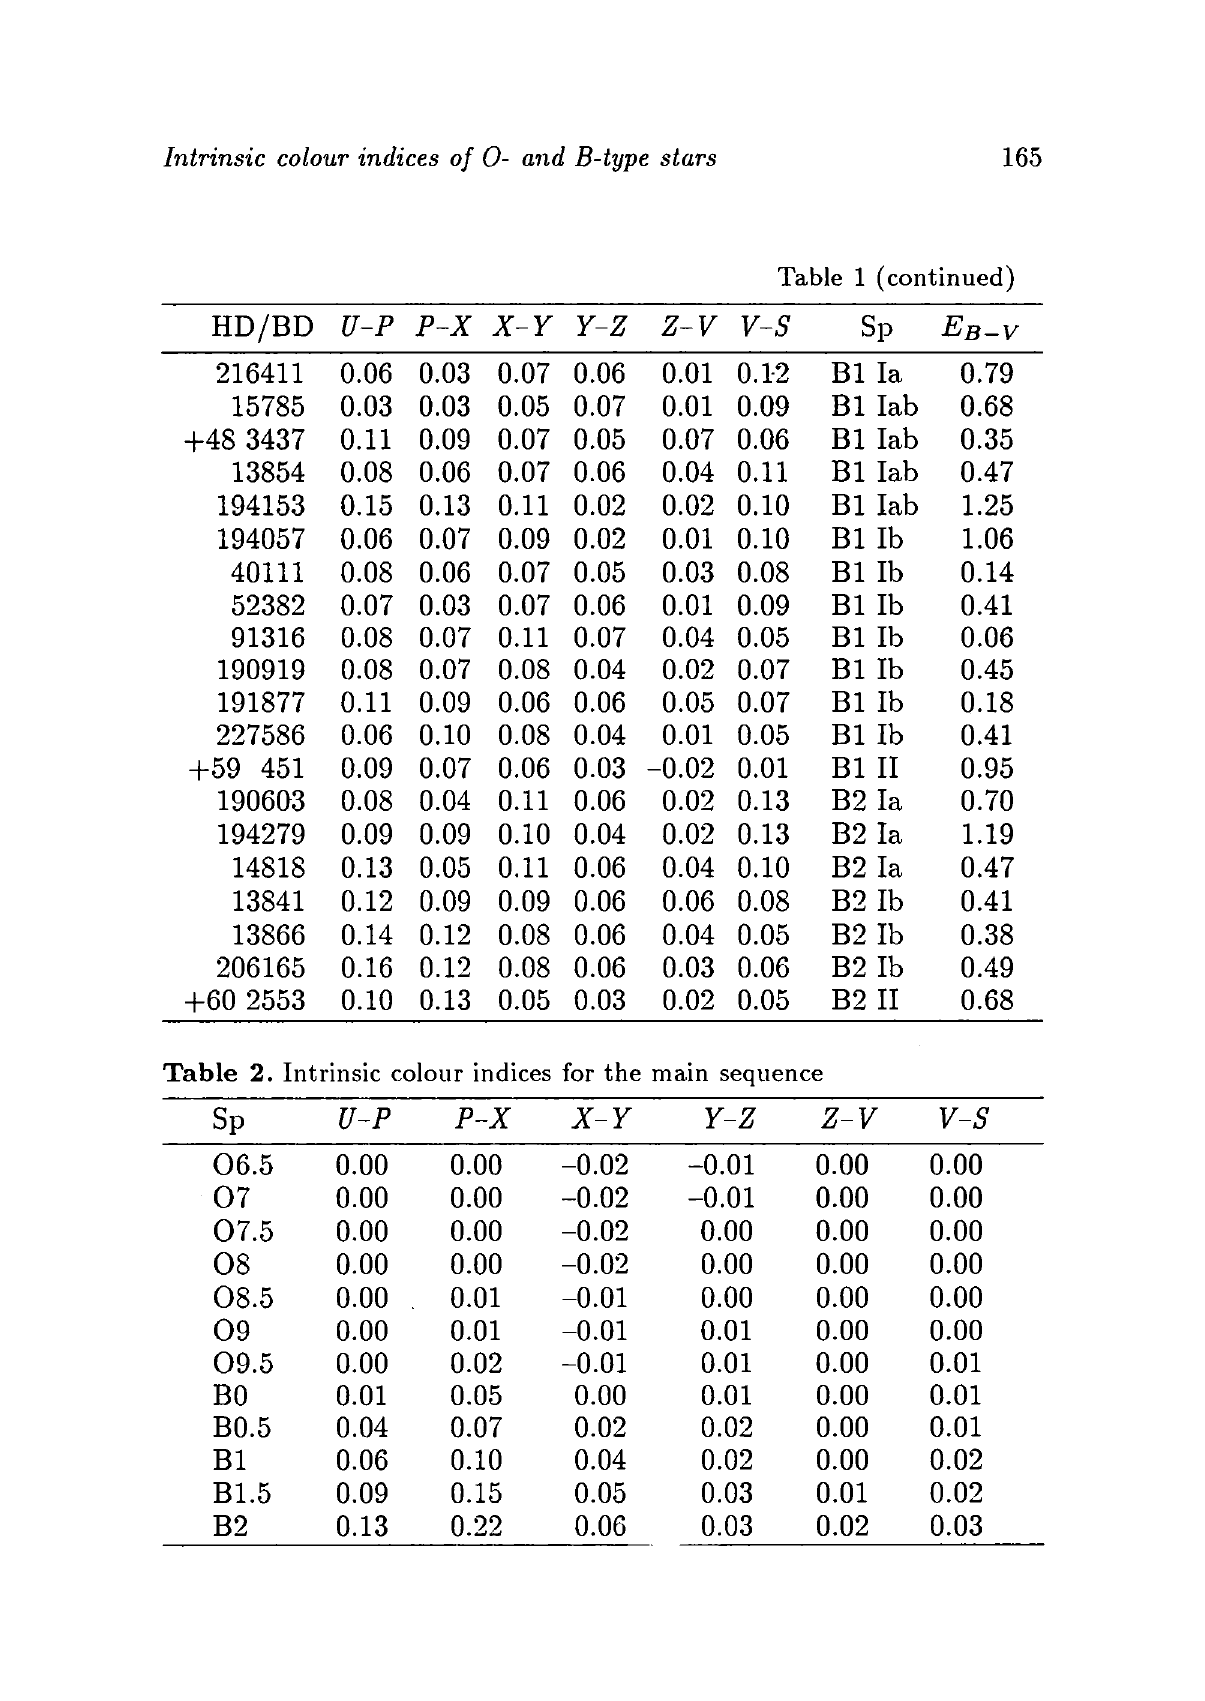
Table 2. Intrinsic colour indices for the main :